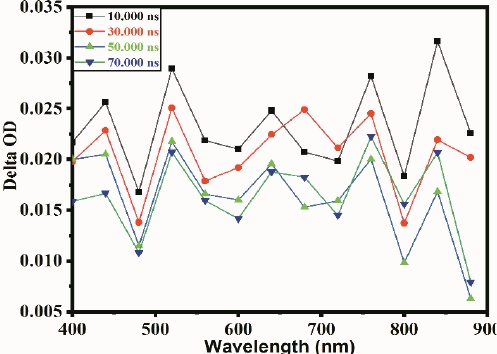
Figure 2. TAS spectrum recorded in the presence of CH 3 OH as holes scavenger of LaMn 0.6 Ni 0.4 O 3.